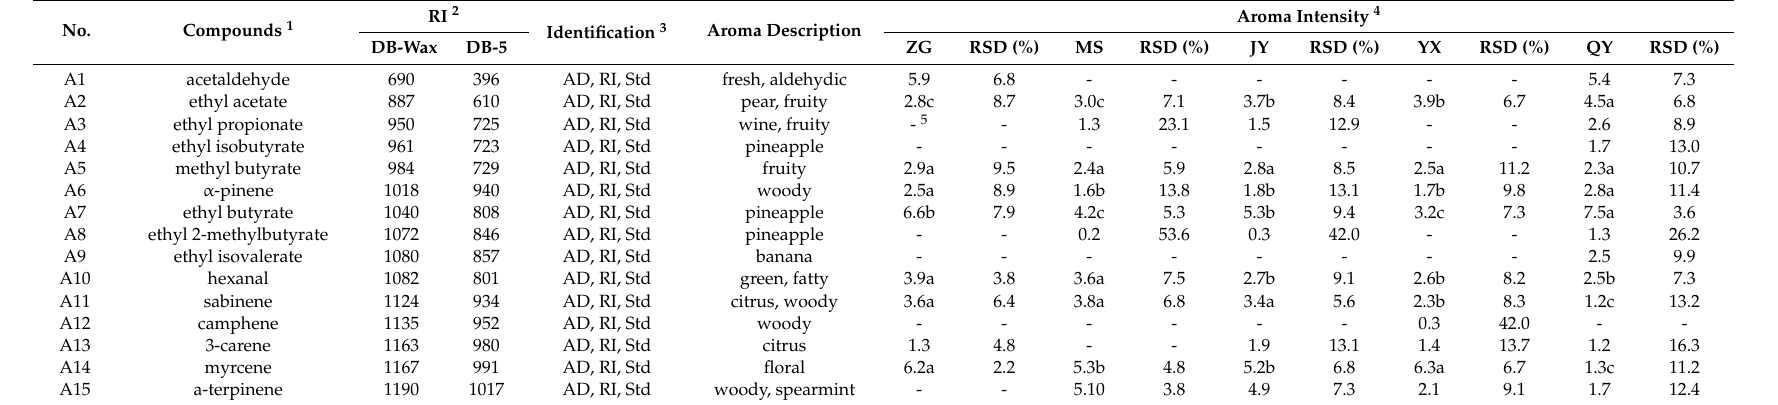
Table 2. Aroma compounds of five sweet oranges by GC-O analysis with aroma description and aroma